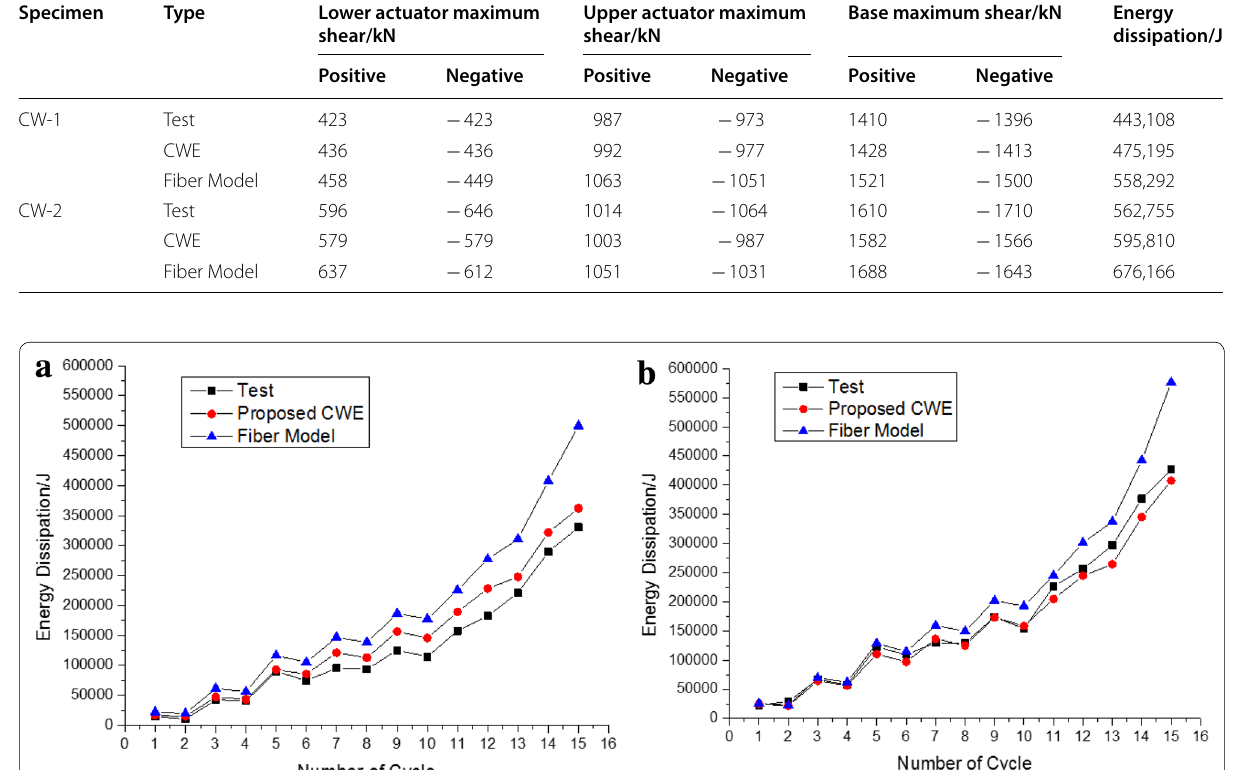
Table 5 The comparisons of selected indicators from CWE and test ones.